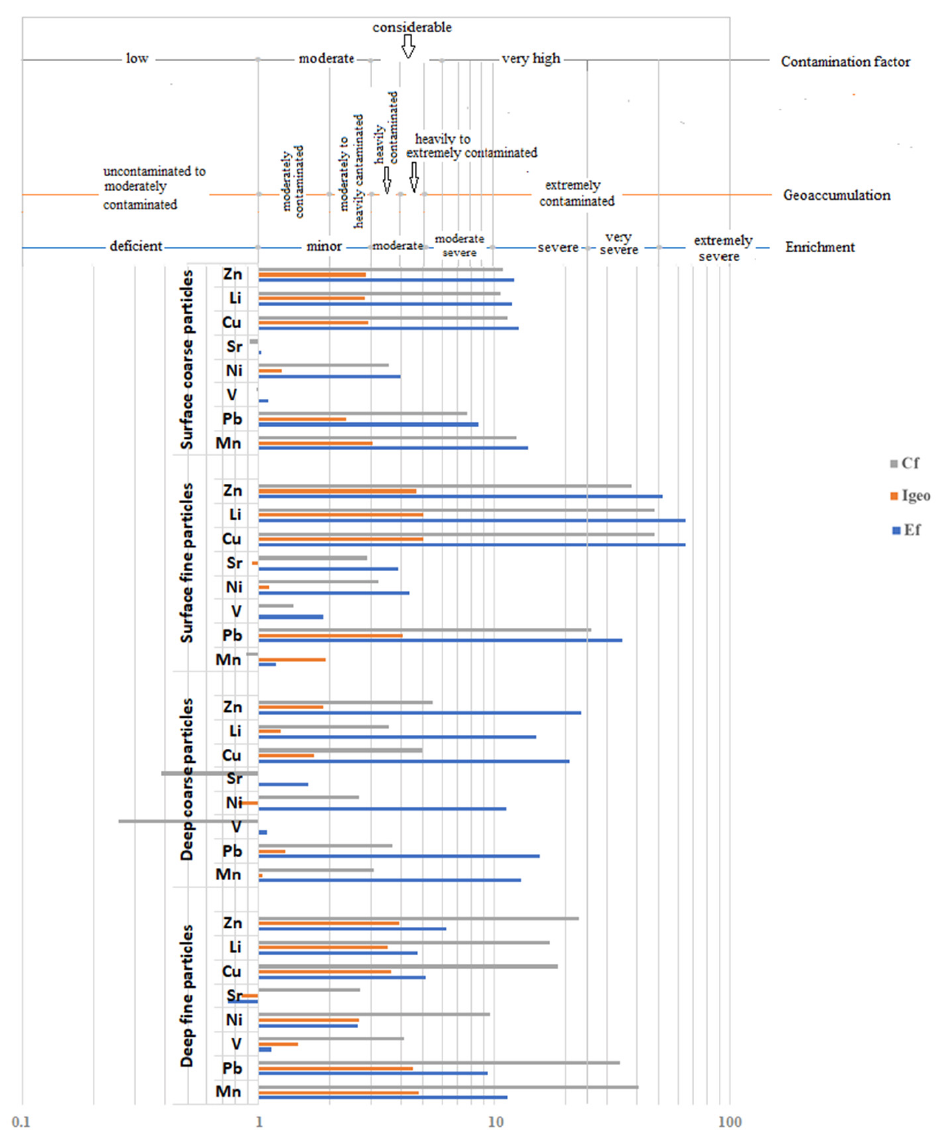
Figure 5. Results of Cf, Igeo, and Ef produced by metals in suspended sediments. On the other hand, the SPR ranged from 0.4 to 238 values, where Ca, Mn, and Pb showed the highest SPR-values, see Figure 6. Likewise, the highest RAC percent (>20%) were shown by Mg, Ca, Mn, Cu, Li, Sr, and